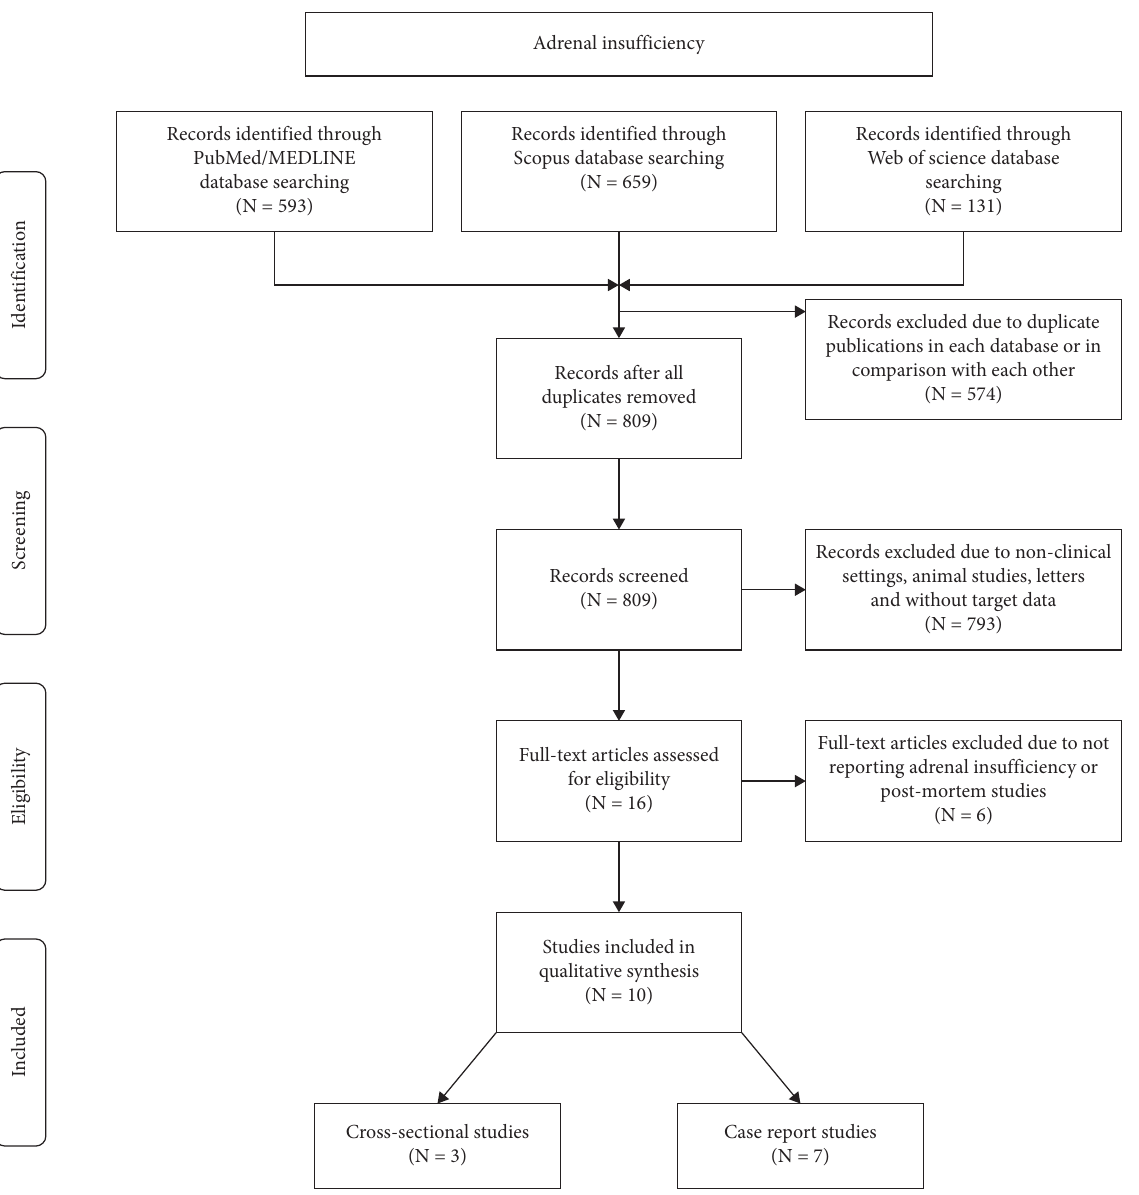
Figure 1: Flow diagram of current